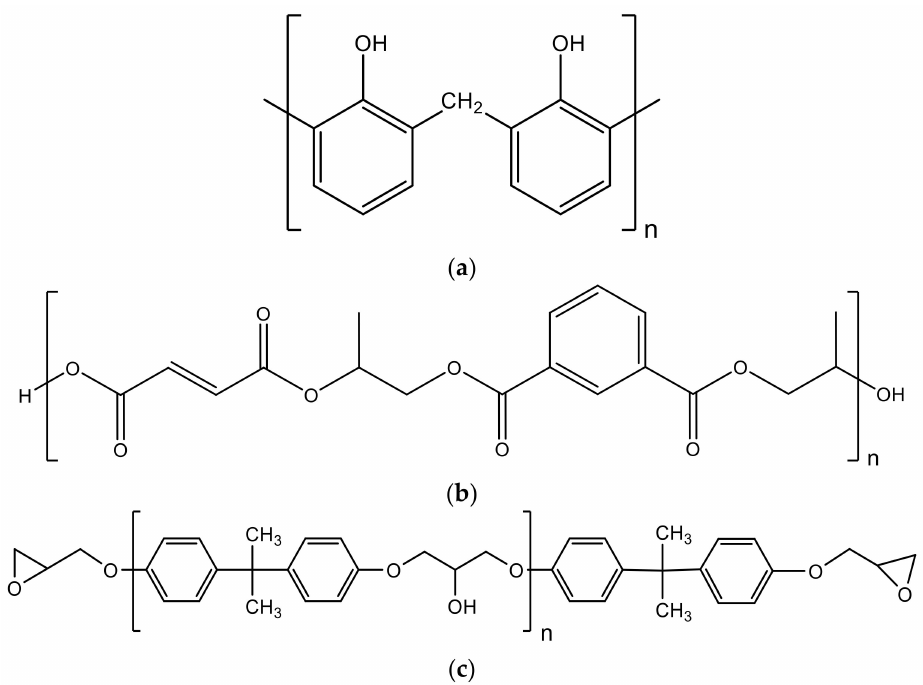
Figure 8. Examples of the chemical structures of: ( a ) Phenol-formaldehyde, ( b ) unsaturated polyester, and ( c ) epoxy resins (n: Number of repeat